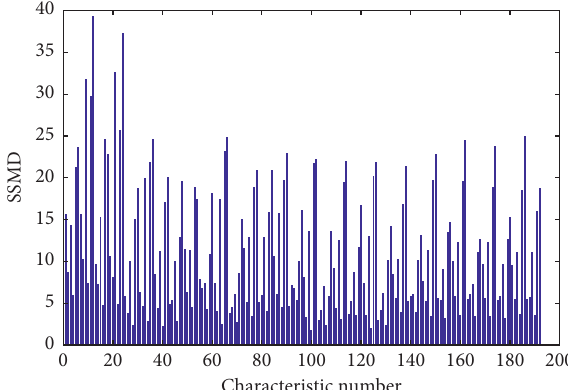
Figure 23: The SSMD of 192 statistical features of training